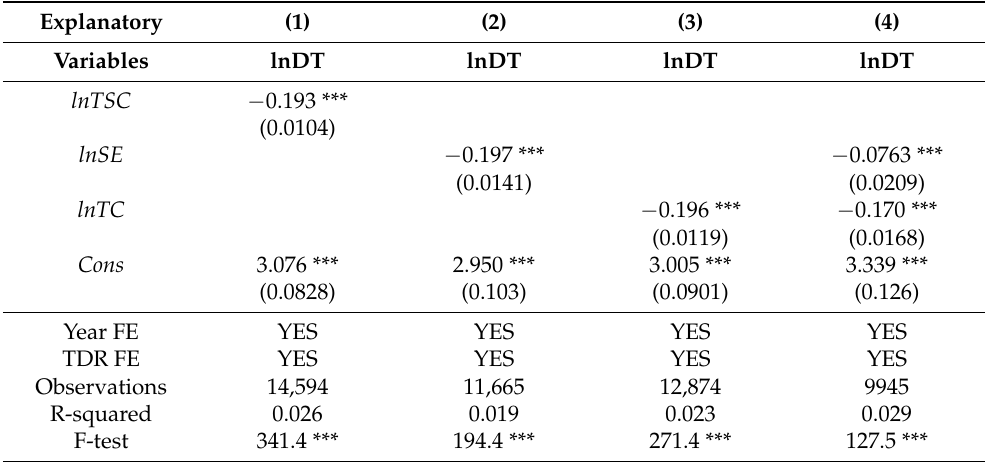
Table 4. TSC effect of HSR on destination development (3 h).